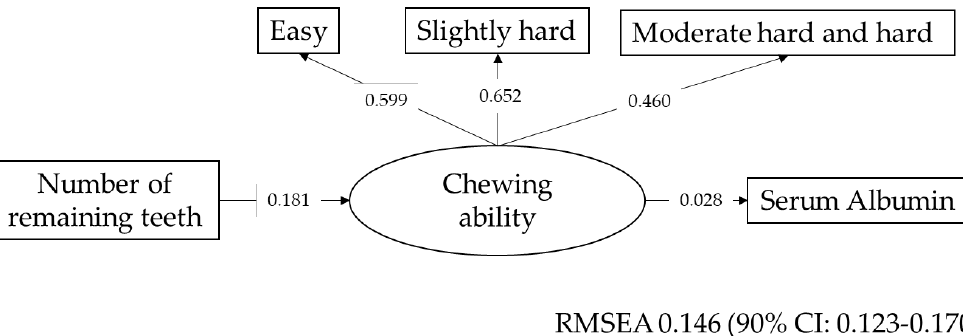
Figure 3. Correlations among number of remaining teeth, chewing ability, and serum level of albumin.